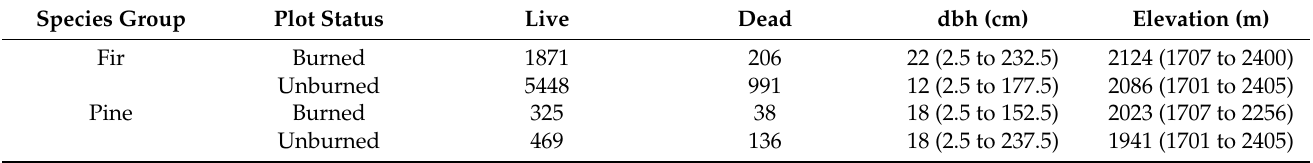
Table 2. Summary statistics of data used in models of individual tree mortality probabilities. Columns for dbh and elevation show median and range of stem diameters. Plots had to have at least five fir or pine individuals to estimate plot-level intercepts for generalized linear mixed models (GLMMs).